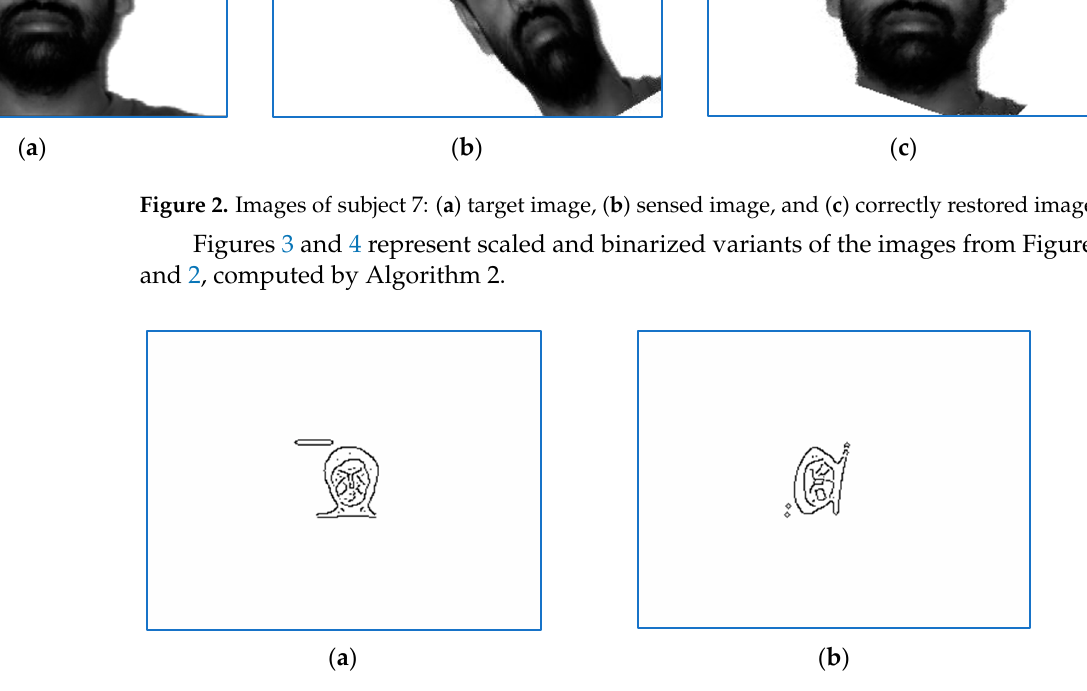
Figure 3. Images for subject 10, scaled and binarized, s1 = 4: ( a ) target; ( b ) sensed.